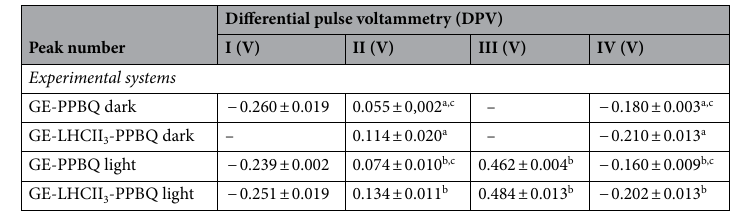
Table 1. Average potentials of peaks at the voltammograms registered for oxidation and reduction processes of GE-PPBQ and LHCII 3 -GE-PPBQ under dark and light conditions. The average values ± SD were calculated from 4 to 7 independent experiments. Values marked with letters indicate a significant difference ( p < 0.05) between GE-PPBQ and GE-LHCII 3 -PPBQ measured under dark ( a ) or light ( b ) conditions as well as between dark and light measurements for GE-PPBQ ( c